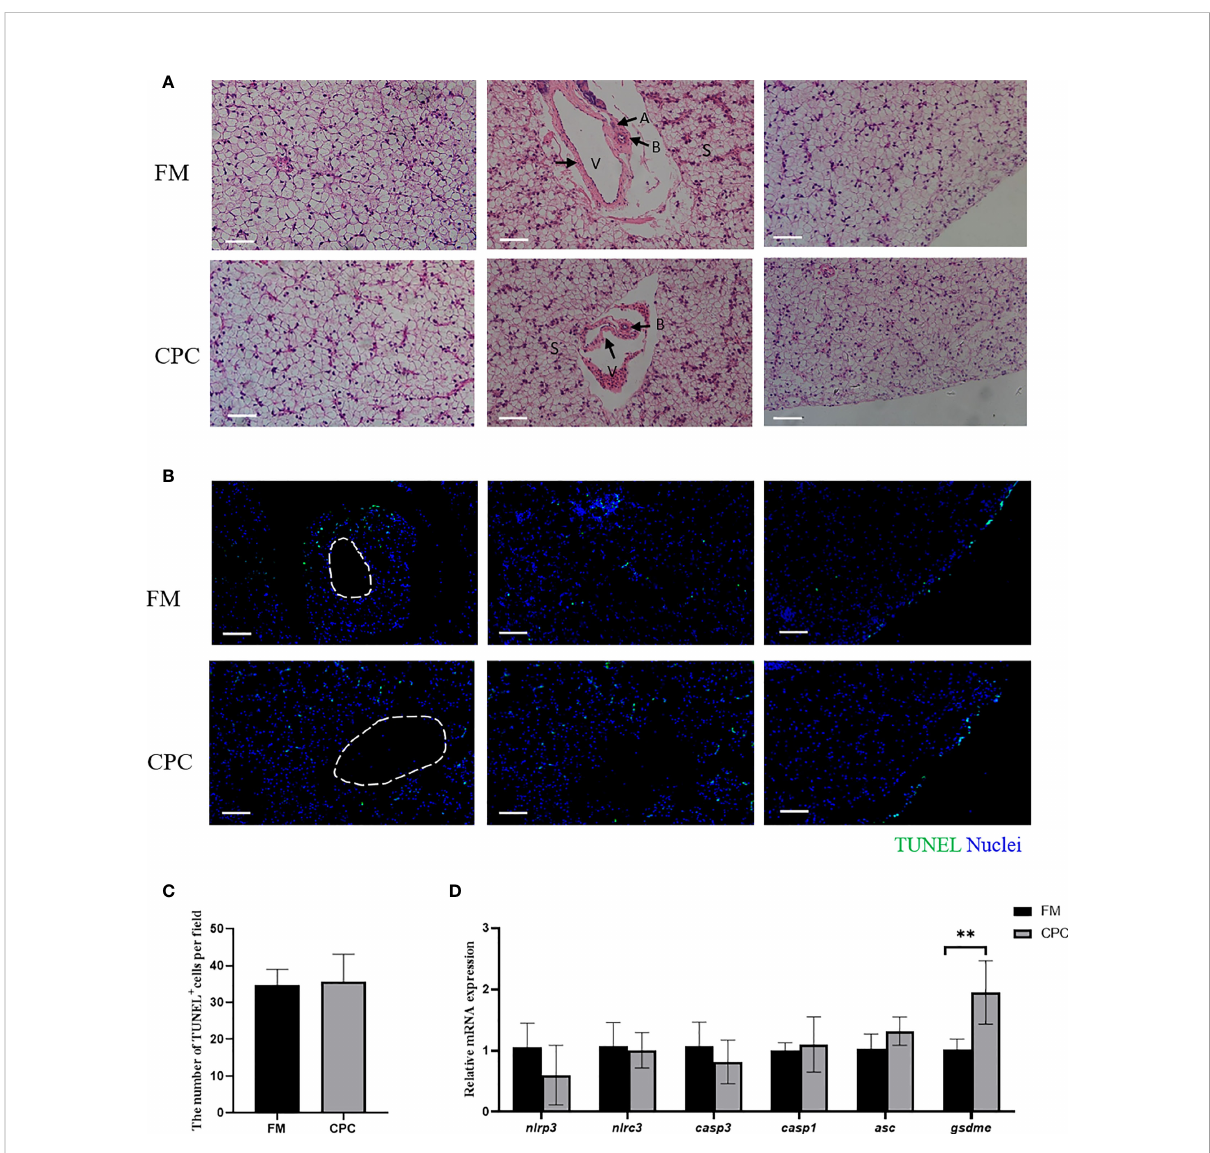
FIGURE 2 Largemouth bass liver structure along with the programmed cell death was not signi fi cantly affected after dietary CPC replacing fi shmeal. (A) The H.E. staining results of juvenile largemouth bass liver fed with FM and CPC for 8 weeks. V: veins; B: bile ducts; A: arterial; S: sinusoid. Scale bars, 50 m m. (B) TUNEL assay with immuno fl uorescence microscope on liver tissue to detect the cells experiencing programmed cell death. Scale bars, 100 m m. (C) The calculated number of TUNEL + cells in liver of two groups. (D) The relative mRNA expression levels of genes involved in apoptosis and pyroptosis ( nlrp3, nlrc3 , casp1, casp3, asc and gsdme ) in the liver of juvenile largemouth bass in both FM group and CPC group. All data was analyzed with student ’ s t-test and data are means ± SD (n = 6). *P< 0.05; **P< 0.01; ***P<